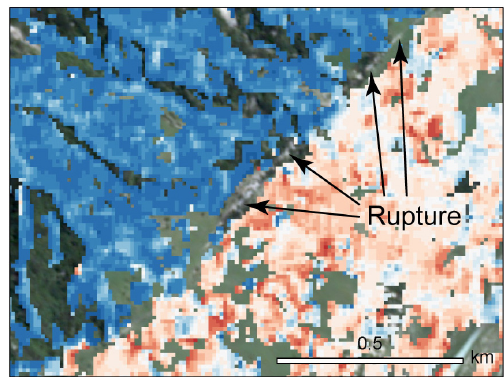
Figure 6. Horizontal surface displacements from PlanetScope im- ages of 27 October–21 November 2016, W–E component. Back- ground: PlanetScope image of 21 November with the surface rup- ture clearly visible. Location: rectangle D of Fig.